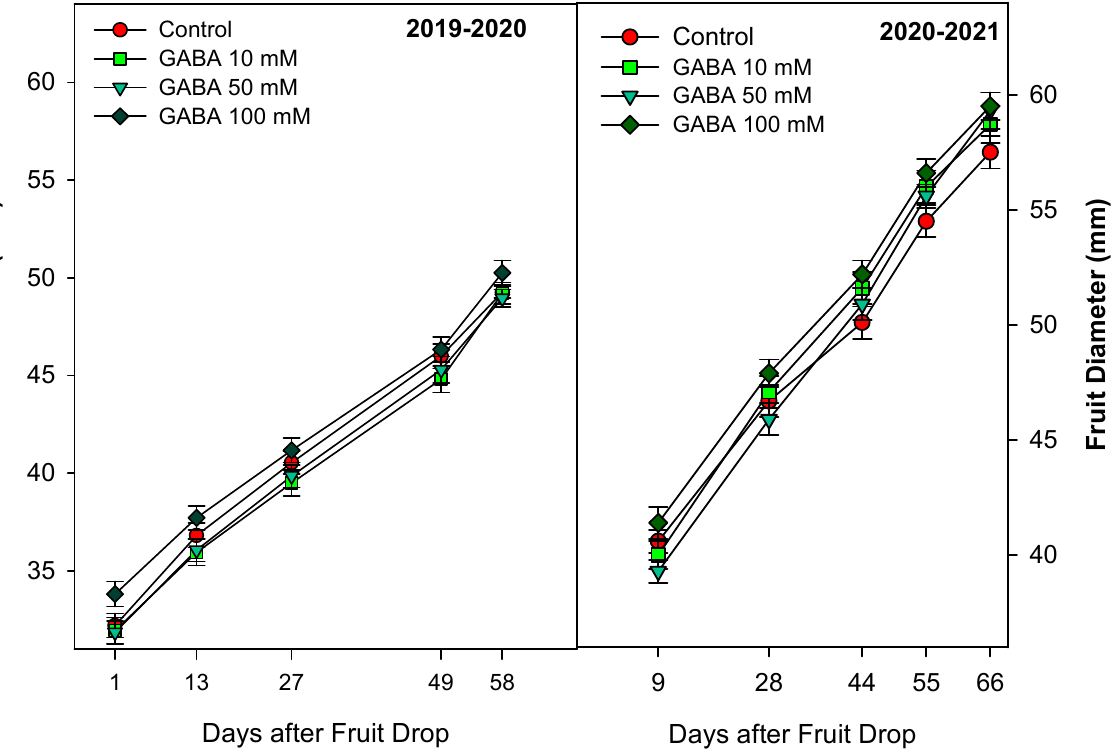
Figure 2. Fruit diameter (mm) in the ‘Fino-95’ lemon fruit during on-tree fruit development in the control and GABA-treated trees at 10, 50, and 100 mM. Data are the mean ± SE.